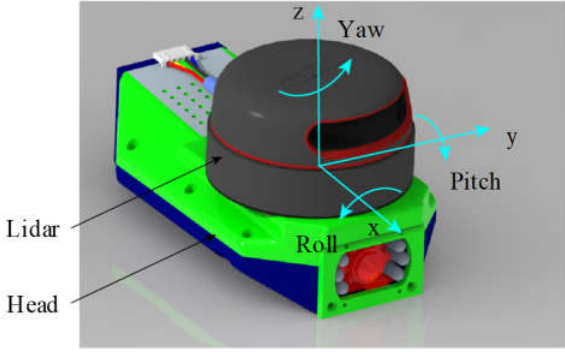
Figure 5. Schematic diagram of snake robot head pose.